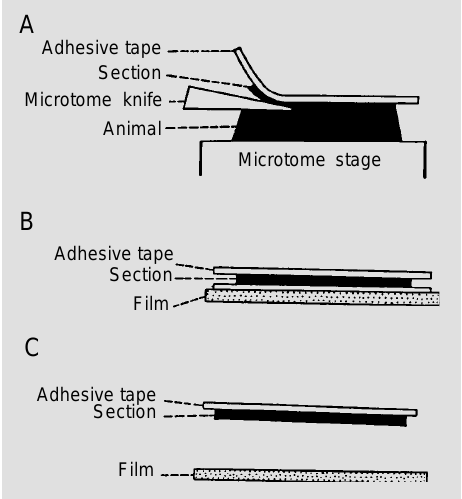
Figure 1 - Diagrams showing the procedures for whole body ra- dioautography. A, A frozen ani- mal is fixed on the microtome stage and sectioned longitudi- nally and adhesive tape is at- tached to the section. B, After the cryosection is dried, the sec- tion is placed in contact with an X-ray film or tritium film (Kodak) in the darkroom and exposed. C, After exposure, the film and the section are separated and the film is